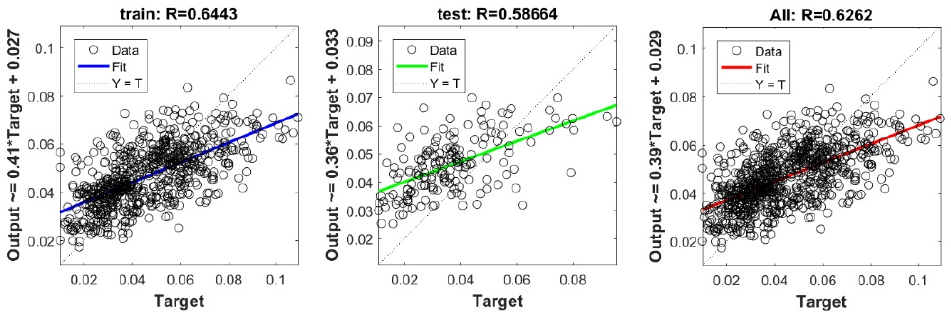
Figure A20. Scatter plots between target and output value by the GT-SVR model.